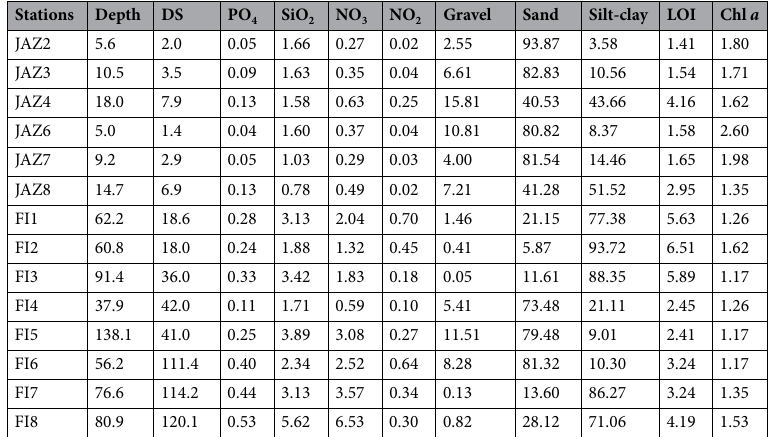
Table 6. Results for the environmental variables analyzed in the sediment stations and from CTD casts. DS, distance to the main shoreline (km); nutrients (PO 4 , SiO 2 , NO 3 , NO 2 ) concentrations in μ M. Gravel, sand and silt-clay particles in percentage of the total sample. Loss on Ignition (LOI) in percentage. Surface Chlorophyll a (Chl a ) measured in μ g L − 1 from CTD casts. Jazan City; JAZ; FI IS, Farasan Islands-Inner shelf; FI OS, Farasan Islands-Outer